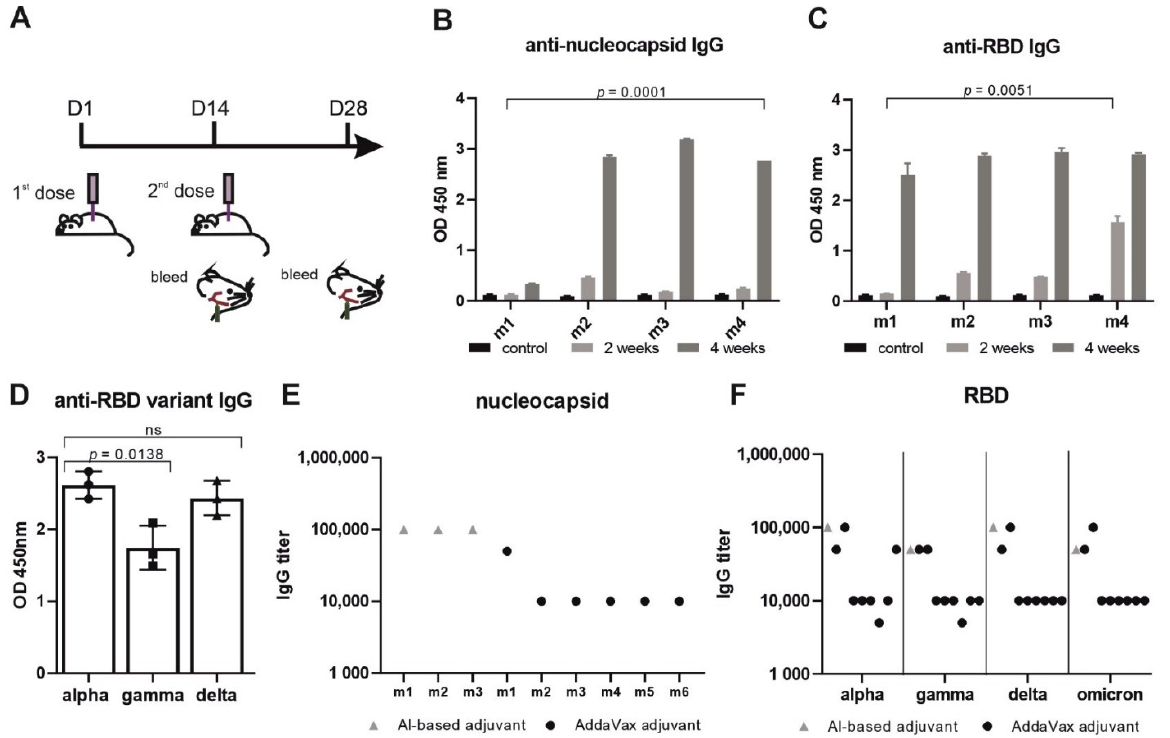
Figure 2. ‘VieVac’ produces prolonged immune responses against all known virus strains. ( A ) Adult C57BL/6J mice ( n = 4) were immunized with 20 µg Imject™ Alum/VieVac (i.p.), with a booster injection carried out 14 days later. Blood sampling was performed 1 h before immunization and 28 days after the first immunization. ( B ) Anti-nucleocapsid and ( C ) anti-spike IgG responses were measured by ELISA upon administration of Imject™ Alum/’VieVac’ in 4 mice (m1, m2, m3, m4) 2 weeks (gray) or 4 weeks after the first injection (dark gray) as compared to controls (black). ( D ) Anti-RBD IgG cross-reactivity in mice ( n = 3) against the alpha variant, relative to the gamma and delta variants treated with the prime-booster mode of Imject™ Alum/’VieVac’ 90 days prior. ( E ) Anti-nucleocapsid IgG end-titer in Imject™ Alum/VieVac (gray) and AddaVax™/’VieVac’ (black) prime-booster-immunized mice. ( F ) Anti-RBD IgG end-titer (alpha, gamma, delta, omicron variants) in Imject™ Alum/’VieVac’ (gray) and AddaVax™/’VieVac’ (black) prime-booster-immunized mice. 2.12. ELISA